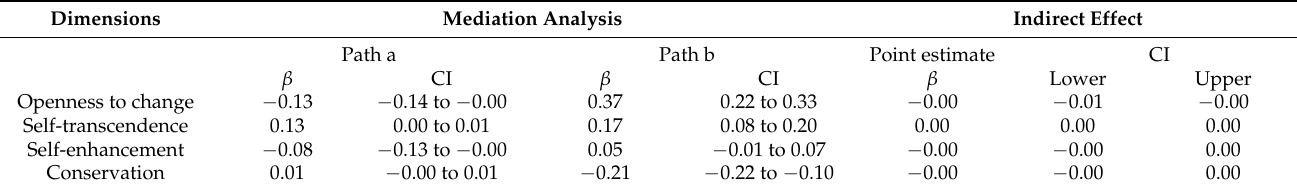
Table 3. Mediation of the effects of age on risk intelligence through values (standardized β ).